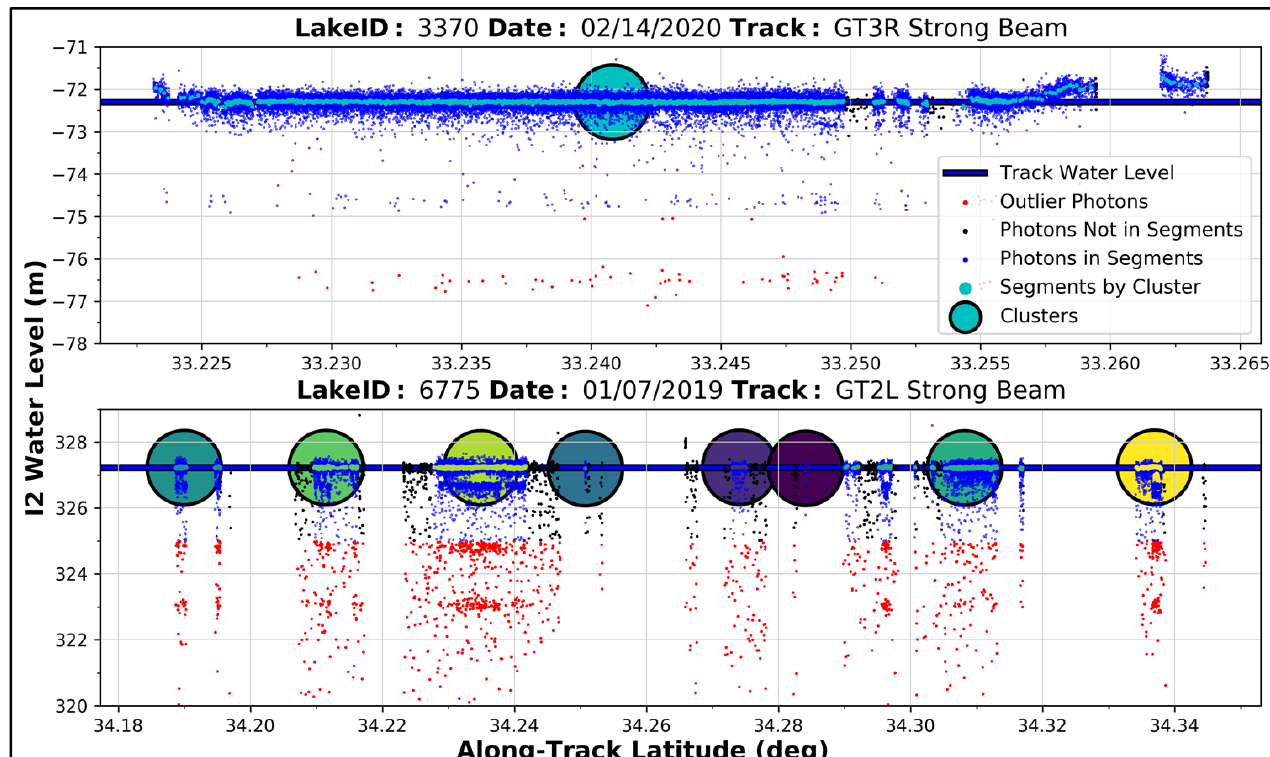
Figure 3. Example ATL03 photons, segmented photons, and clustered segments for a daily data plot at an example lake and reservoir. Each subplot is for a single “strong” beam track and visually shows the photon to cluster hierarchy of our processing workflow. Red photons are filtered outliers, black photons are not used in the segmentation, blue photons are assigned to a segment, segments are colored based on their assigned cluster, and clusters consist of those segments of the same color. The thick blue/black horizontal line is the assigned water level for that track based on the cluster median.